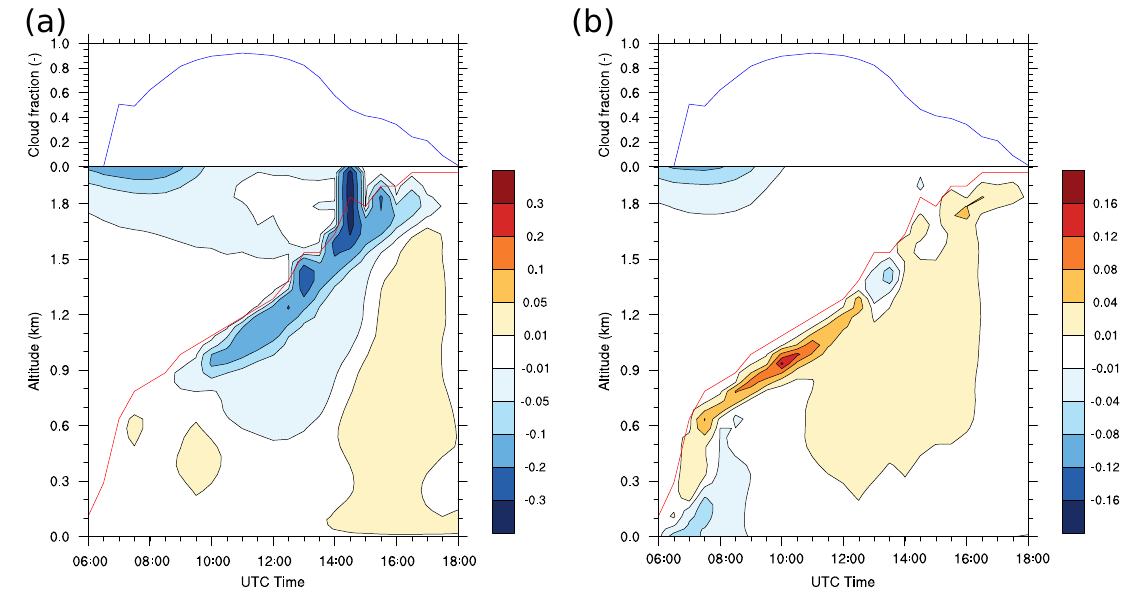
Figure 6. (a) Diurnal evolution of the segregation coefficient for isoprene and OH in the biogenic case and (b) for ALD2 and OH in the anthropogenic case. The red line represents the boundary layer height as determined by the tracer approach. The diurnal evolution of cloud fraction (blue line) is added above each